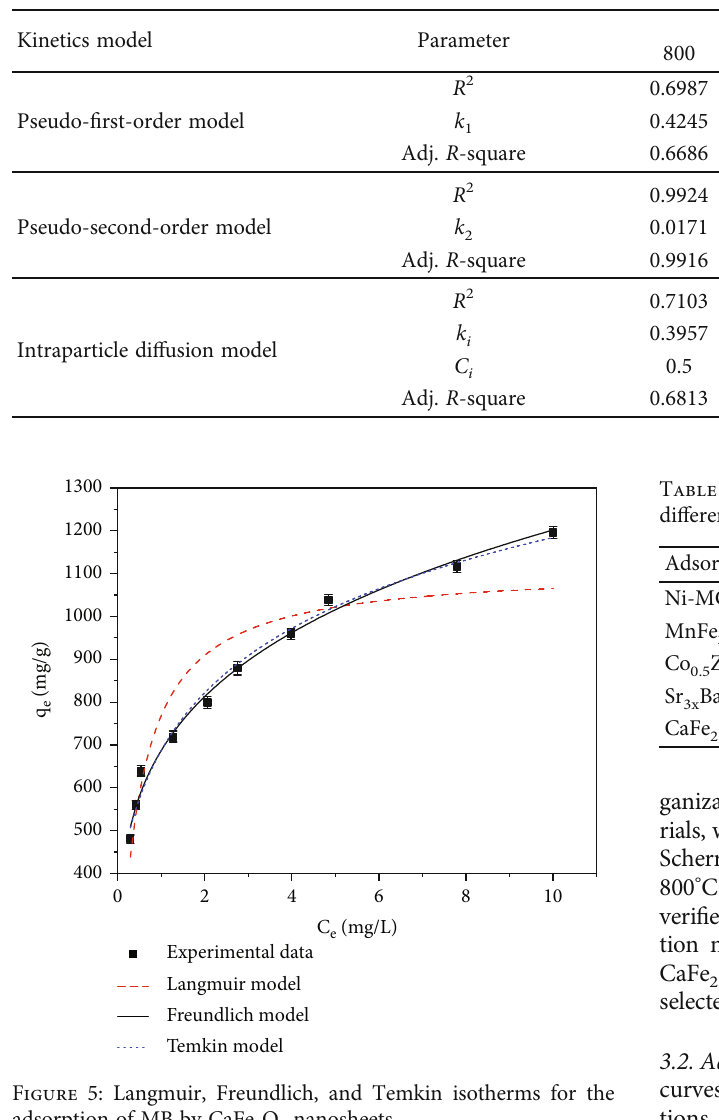
O nanosheets. 2 4 O nanosheets for MB 2 4